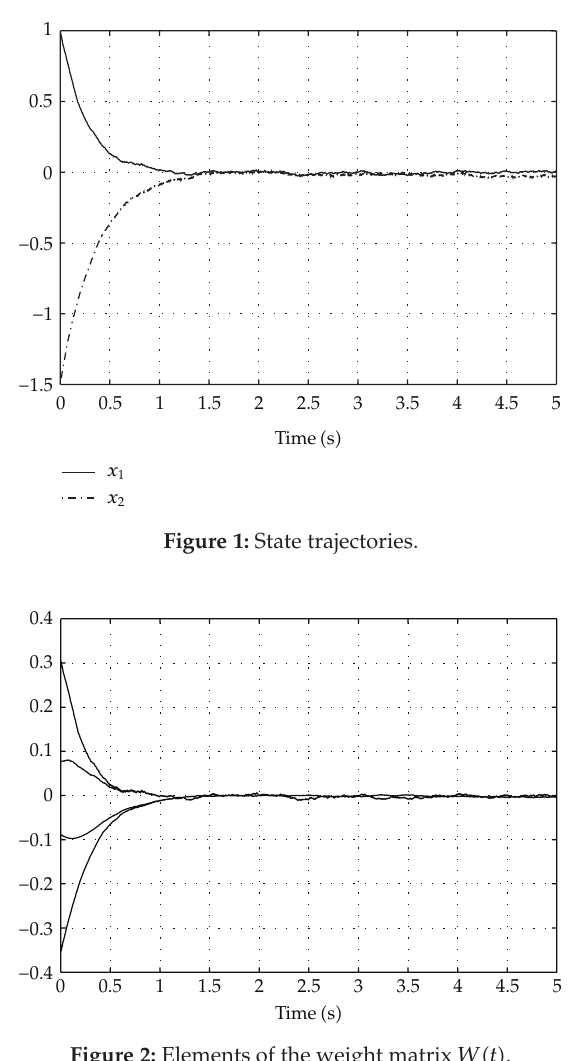
Figure 2: Elements of the weight matrix W (cid:2) t (cid:3)